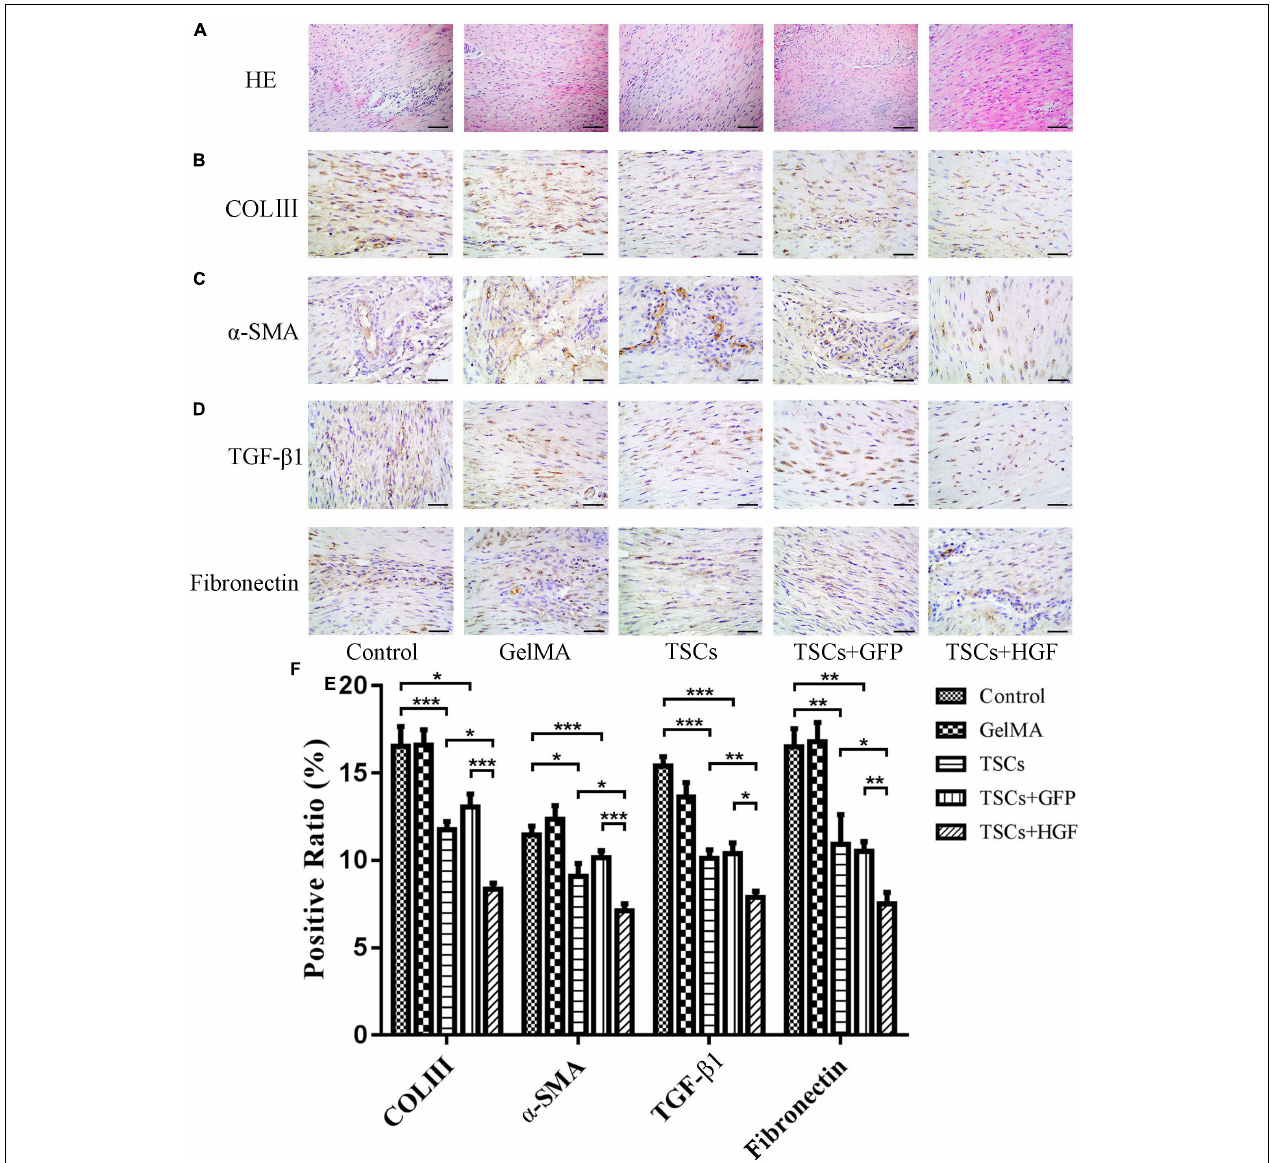
FIGURE 4 | Impact of treatment with TSCs expressing HGF (TSCs + HGF) on tendon levels of fibrosis-relevant proteins at 4 weeks postsurgery. (A) H&E stain of the tendon repair site. Immunohistochemical evaluation of (B) COLIII, (C) α -SMA, (D) TGF- β 1, and (E) fibronectin patterns. (F) Quantitation of fibrosis-relevant proteins ( n = 5). Bars: 50 µ m. Data are represented as mean ± SD. * P < 0.05, ** P < 0.01, *** P <